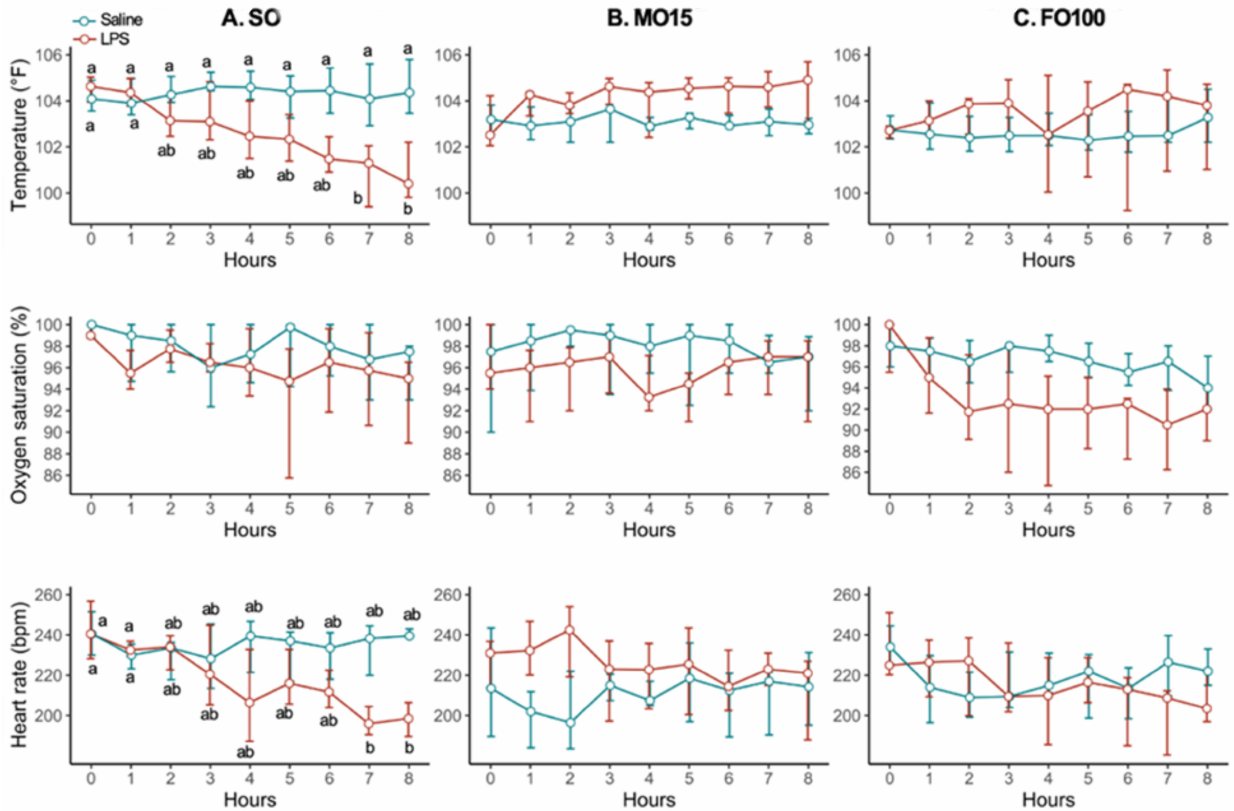
Figure 2. Vital sign changes in pigs during LPS challenge. Hourly recordings in temperature, oxygen saturation, and heart rate by lipid group, SO ( A , n = 16), MO ( B , n = 20), and FO100 ( C , n = 23) lipid groups. Data was presented as line plot showing median and IQR. Groups without common letters are significantly different ( p < 0.05). FO100, 100 percent fish oil; LPS, lipopolysaccharide; MO15, mixed oil with 15% fish oil; SO, 100% soybean